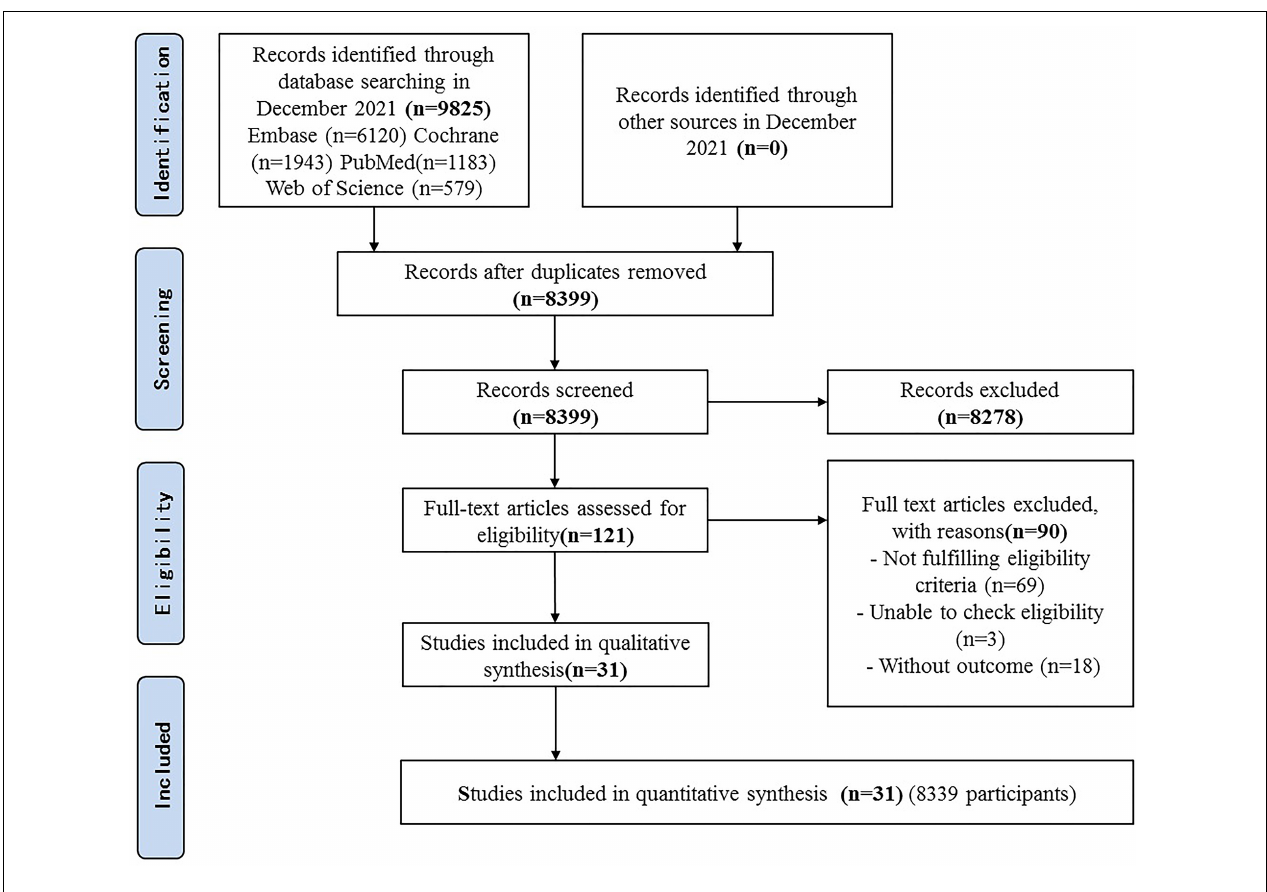
FIGURE 1 | Flow diagram of included